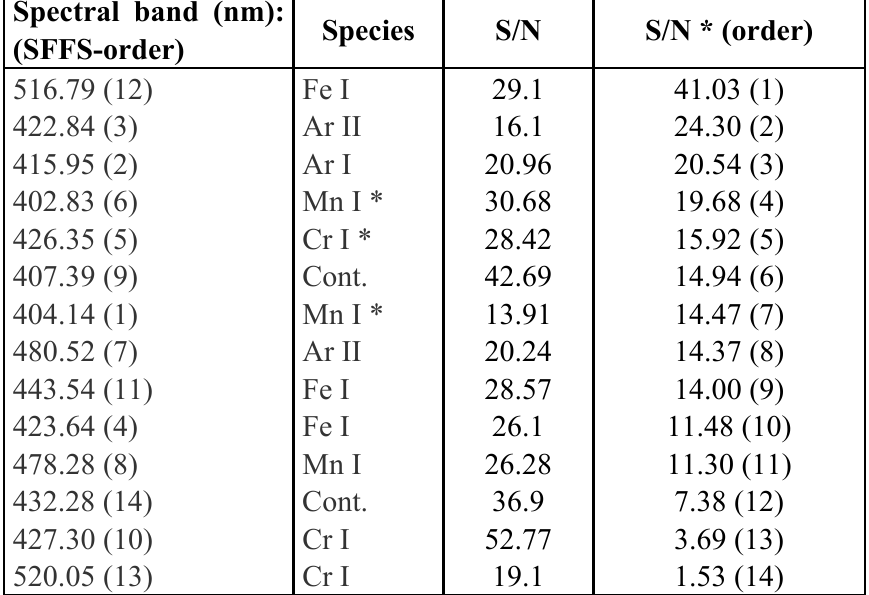
Table 3. Spectral bands selected and listed by SFFS and related to species participating in the plasma: field